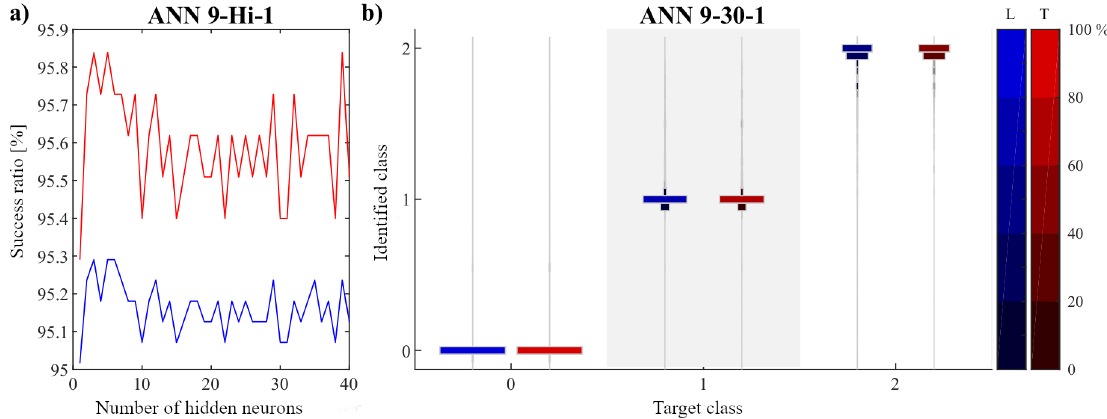
Figure 10. ( a ) Optimization of ANN architecture (9-H-1 ANNs for determination of the number of loosened rows), ( b ) classification results using ANNs with architecture 9-30-1, adopted classes: S00: 0; S11, S22, S33, and S44: 1; S12, S14, S23, and S34: